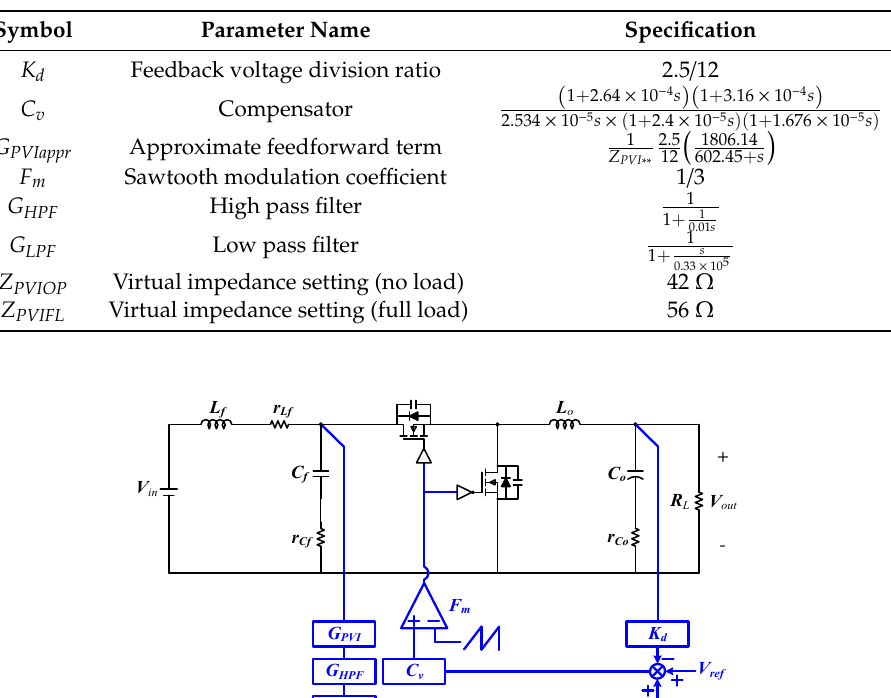
Table 2. Control parameters.